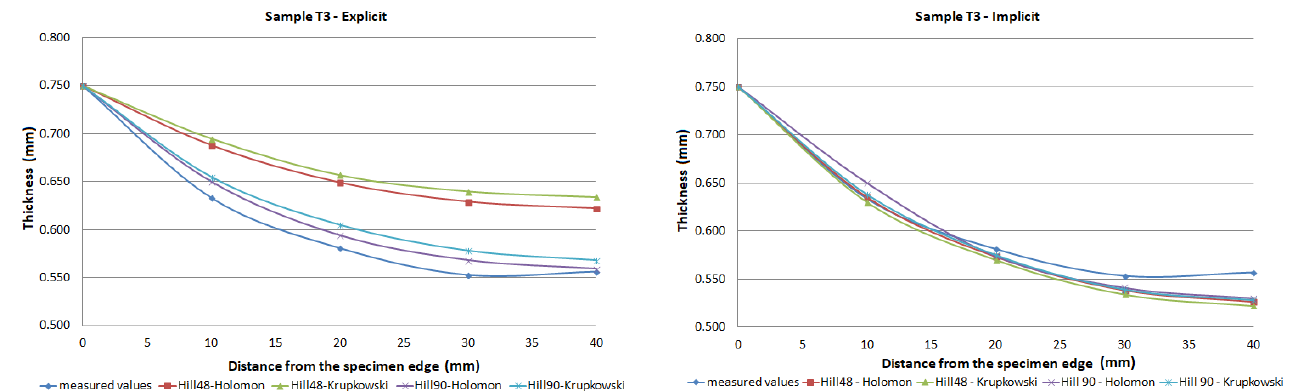
Figure 13. Comparison of predicted thinning values of samples T3 ( left ) and T6 ( right ) using software with explicit solver in program environment.